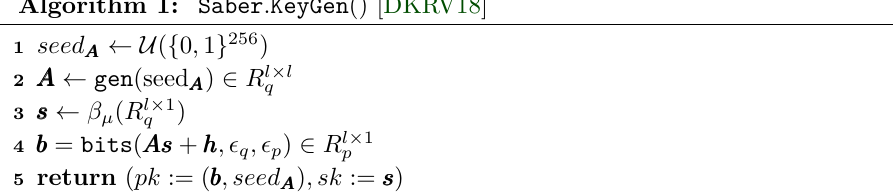
Algorithm 1: Saber . KeyGen ()